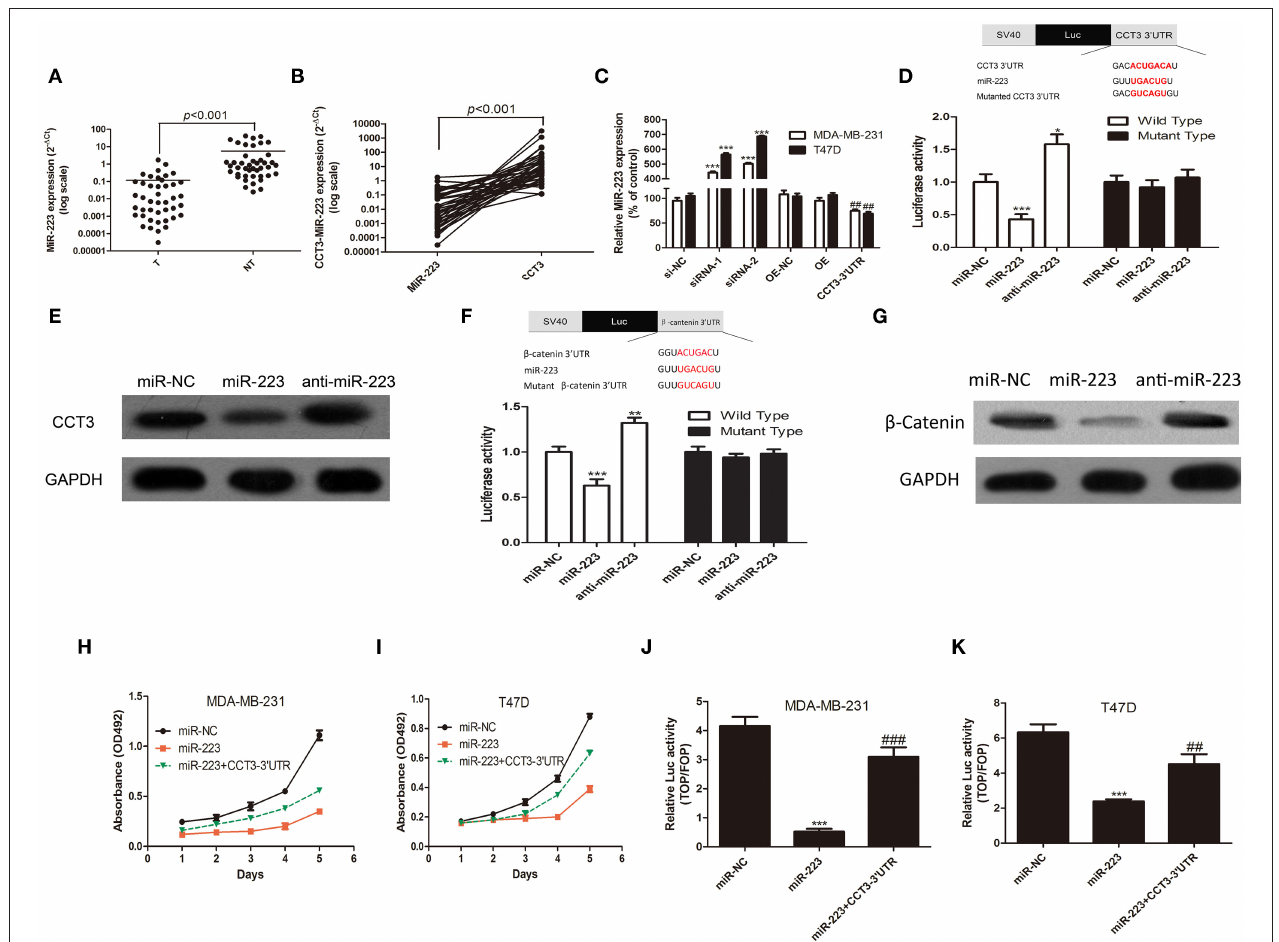
FIGURE 4 | CCT-3 promotes breast cancer cell proliferation through miR-223 suppression. (A) Mann–Whitney test for miR-223 expression in 43 pairs of breast cancer tissues (tumor) and their corresponding non-tumorous tissues (NT) (frozen samples). (B) Wilcoxon signed rank test for miR-223 and CCT-3 in 43 pairs of breast cancer tissues (tumor) and their corresponding non-tumorous tissues (NT) (frozen samples). (C) RNA levels of miR-223 in CCT-3-silenced, CCT-3-overexpressed, and CCT-3 3 ′ UTR overexpressed cells. *** p < 0.001 (siRNA vs. siRNA-NC), ## p < 0.01 (CCT-3 3 ′ UTR vs. OE-NC), t -test. (D) MiR-223 mimics and inhibitor significantly suppressed and upregulated the luciferase activity of wild-type CCT-3 3 ′ UTR, respectively, * p < 0.05, *** p < 0.001, t -test. (E) Protein levels of CCT-3 in miR-223 mimics and inhibitor-treated cell. GAPDH was used as loading control. (F) MiR-223 mimics and inhibitor significantly suppressed and upregulated the luciferase activity of wild-type β -catenin 3 ′ UTR, respectively; ** p < 0.01, *** p < 0.001, t -test. (G) Protein levels of β -catenin in miR-223 mimics and inhibitor-treated cell. GAPDH was used as loading control. MTT assays indicated that miR-223 rescued the anti-proliferation effect of CCT-3 in MDA-MB-231 (H) and T47D (I) . (J,K) TOP/FOP flash indicated that the Wnt/ β -catenin signaling pathway activation was regulated by miR-223 and CCT-3 3 ′ UTR. Values are mean ± SD of three independent experiments. *** p < 0.001 (miR-223 vs. miR-NC), ## p < 0.01, ### p < 0.001 (miR-223 + CCT-3 3 ′ UTR vs. miR-223), t